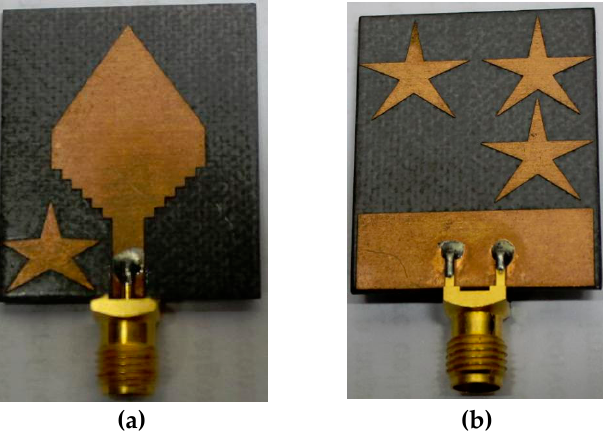
Figure 4. The fabricated prototype: ( a ) front side ( b ) back side.